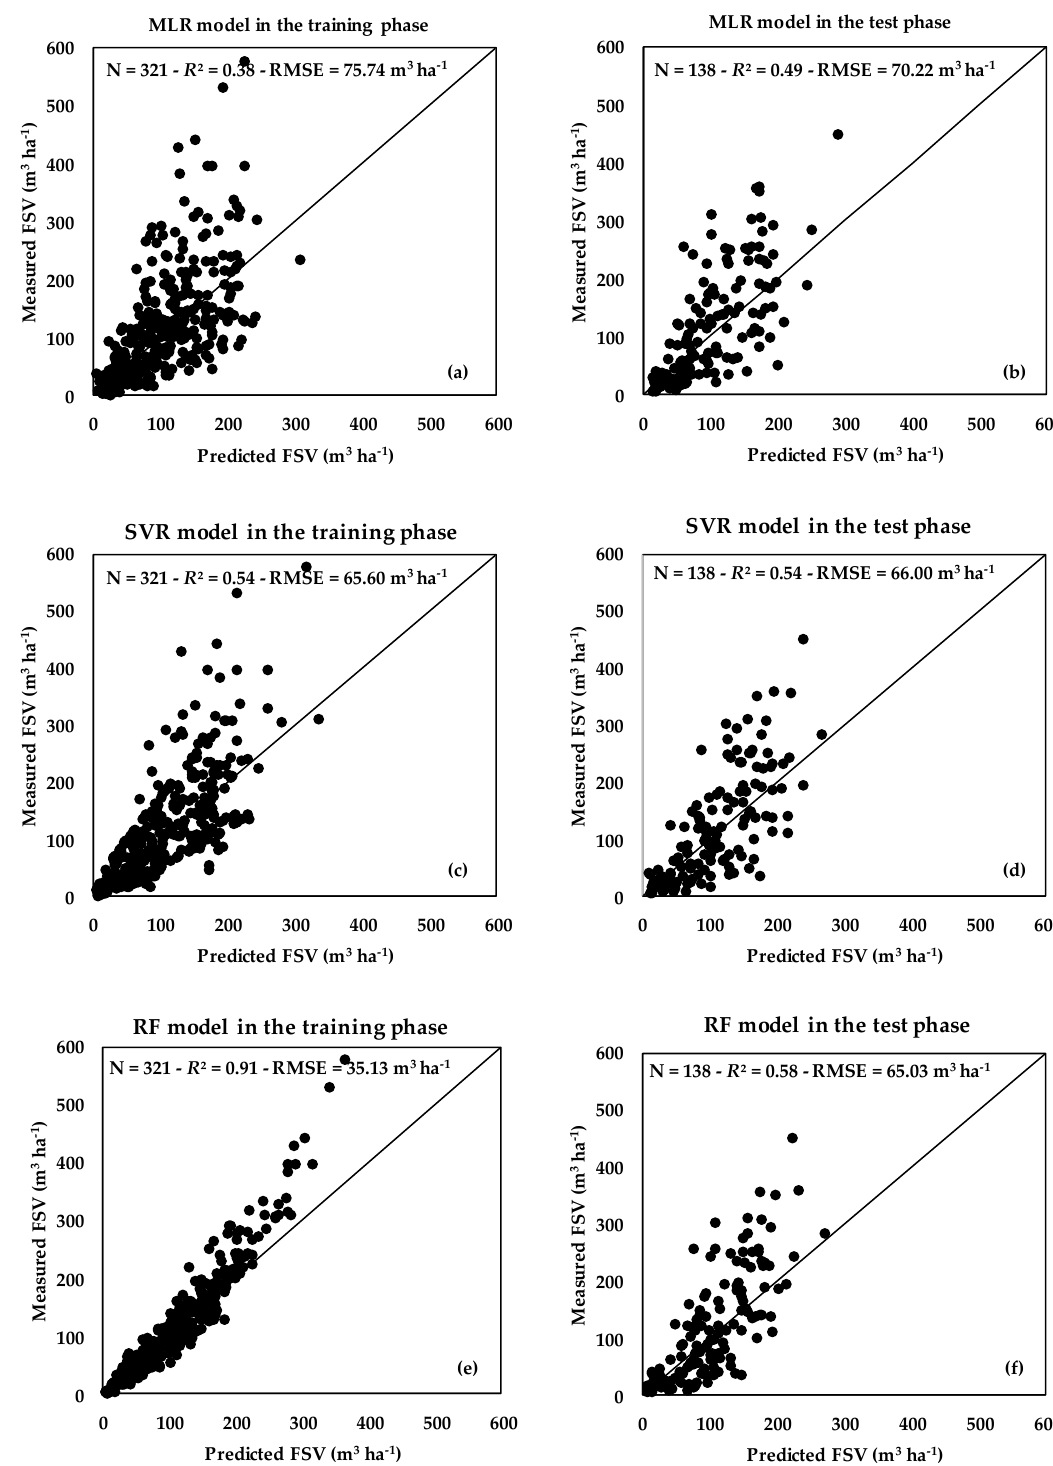
Figure 8. Comparison between measured and predicted FSVs using the three algorithms. ( a ) MLR model prediction versus measured FSV using the training data, ( b ) MLR model prediction versus measured FSV using the test data, ( c ) SVR model prediction versus measured FSV using the training data, ( d ) SVR model prediction versus measured FSV using the test data, ( e ) RF model prediction versus measured FSV based on the training data, and ( f ) RF model prediction versus measured FSV based on the test data.